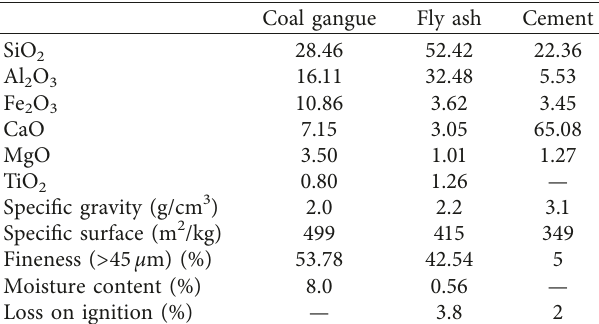
Table 1: Chemical and physical properties of coal gangue, fly ash, and cement [7].